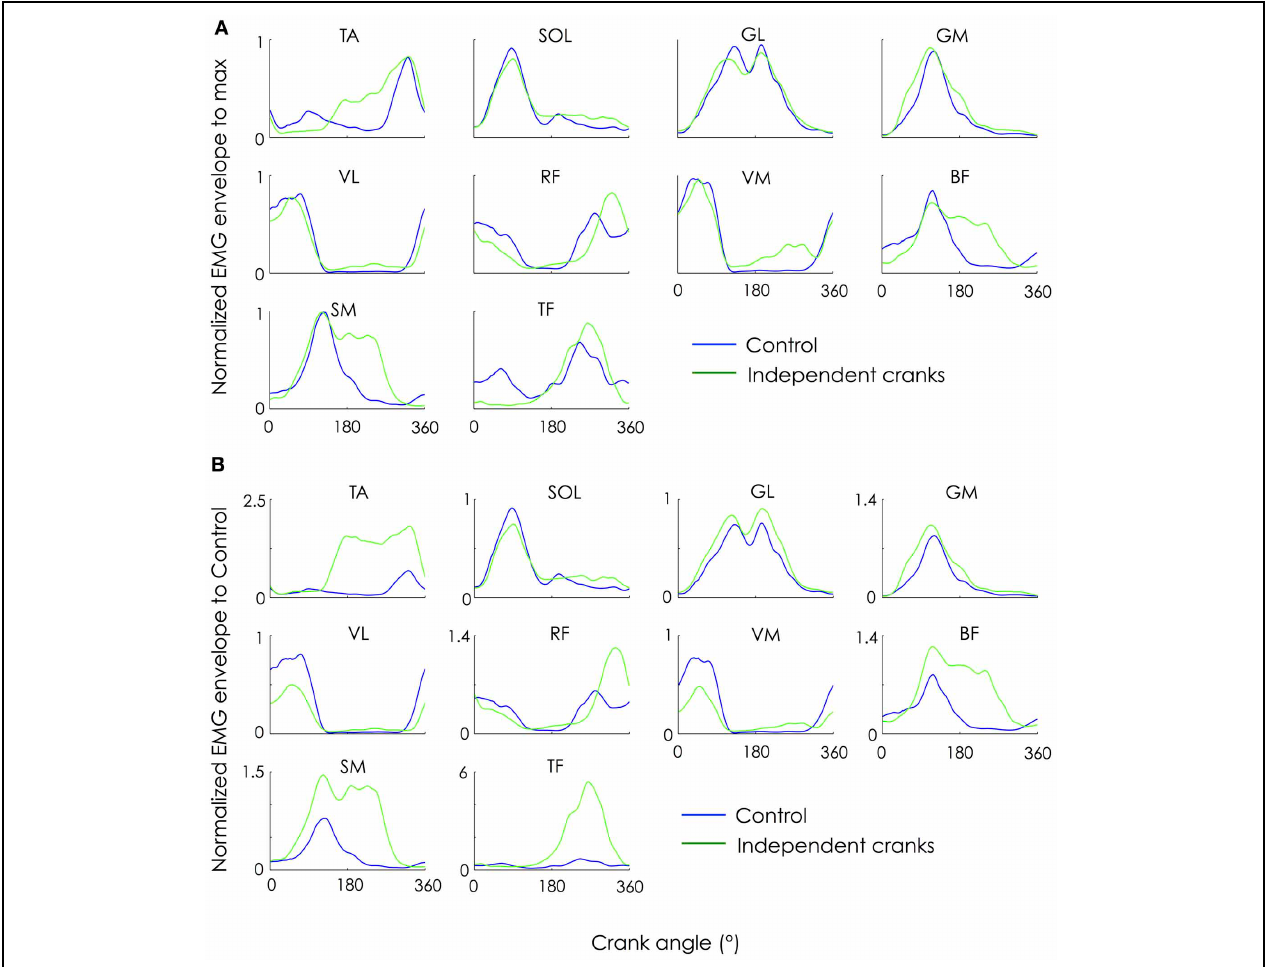
FIGURE 2 | Change in ensemble-averaged EMG patterns. EMG patterns were averaged across 30 consecutive pedaling cycles and expressed as a function of the left crank angle as it rotated from the highest pedal position (0 ◦ ) to the lowest pedal position (180 ◦ ) and back to the highest position. To compare the shape of the EMG patterns, the amplitude was first normalized for each condition by the average of its peak from all cycles (panel A ). To